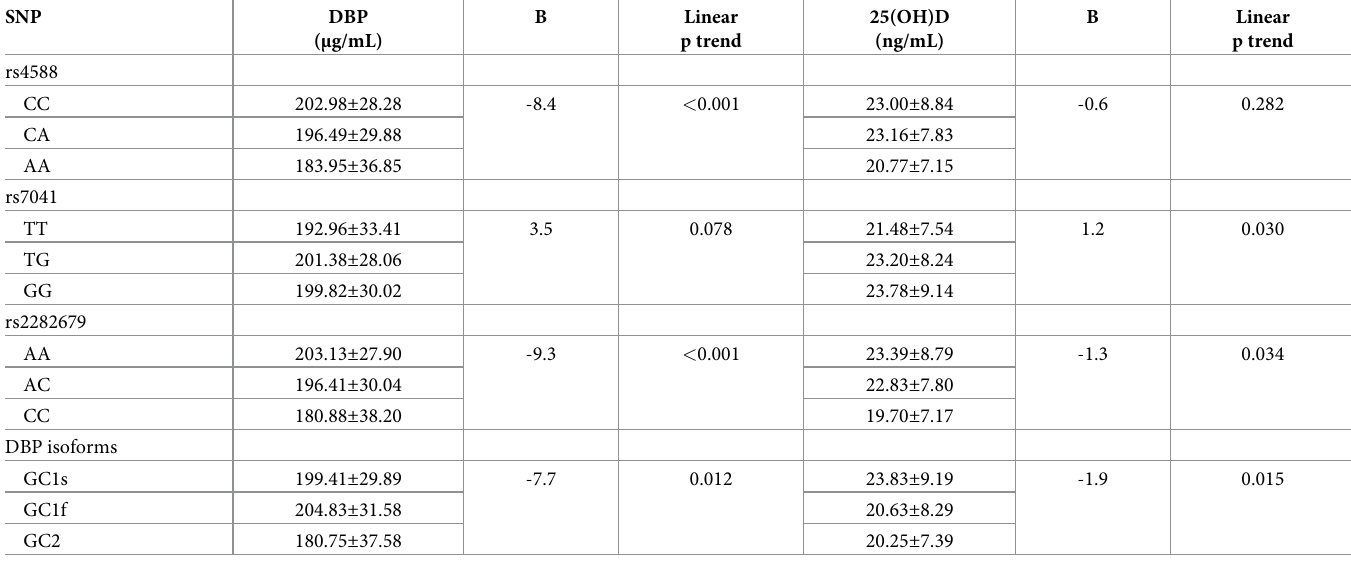
Table 3. DBP and 25(OH)D levels according to GC gene genotype and DBP